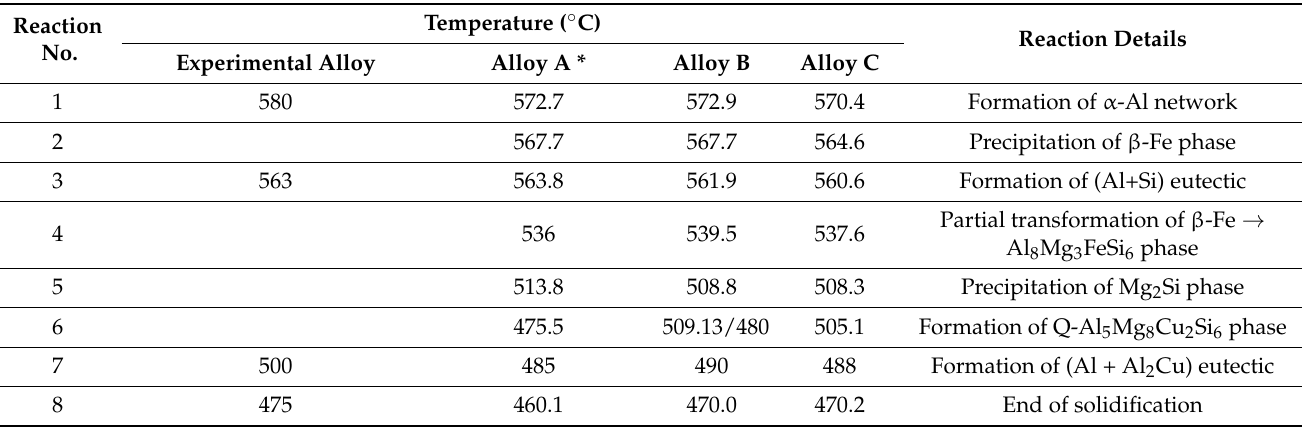
Table 4. Reactions observed during the solidification of the present alloys (0.35 ◦ C/s) using the thermal analysis technique.